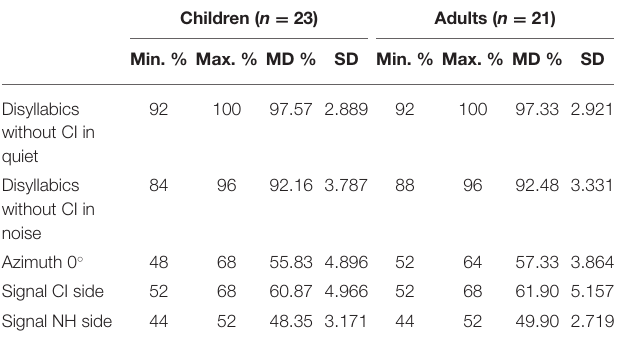
TABLE 3 | Acquired single-sided deafness: speech test results.